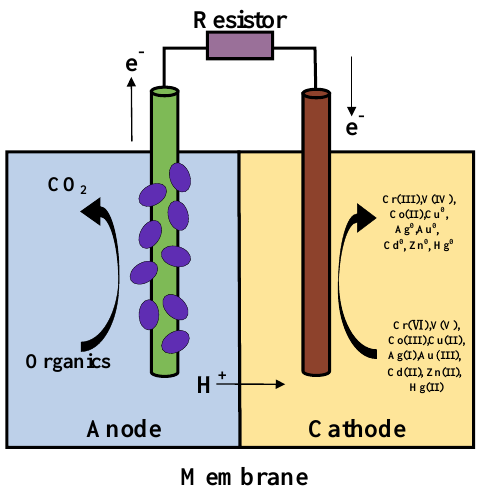
Figure 1. Metals removal on the cathode of MFCs.